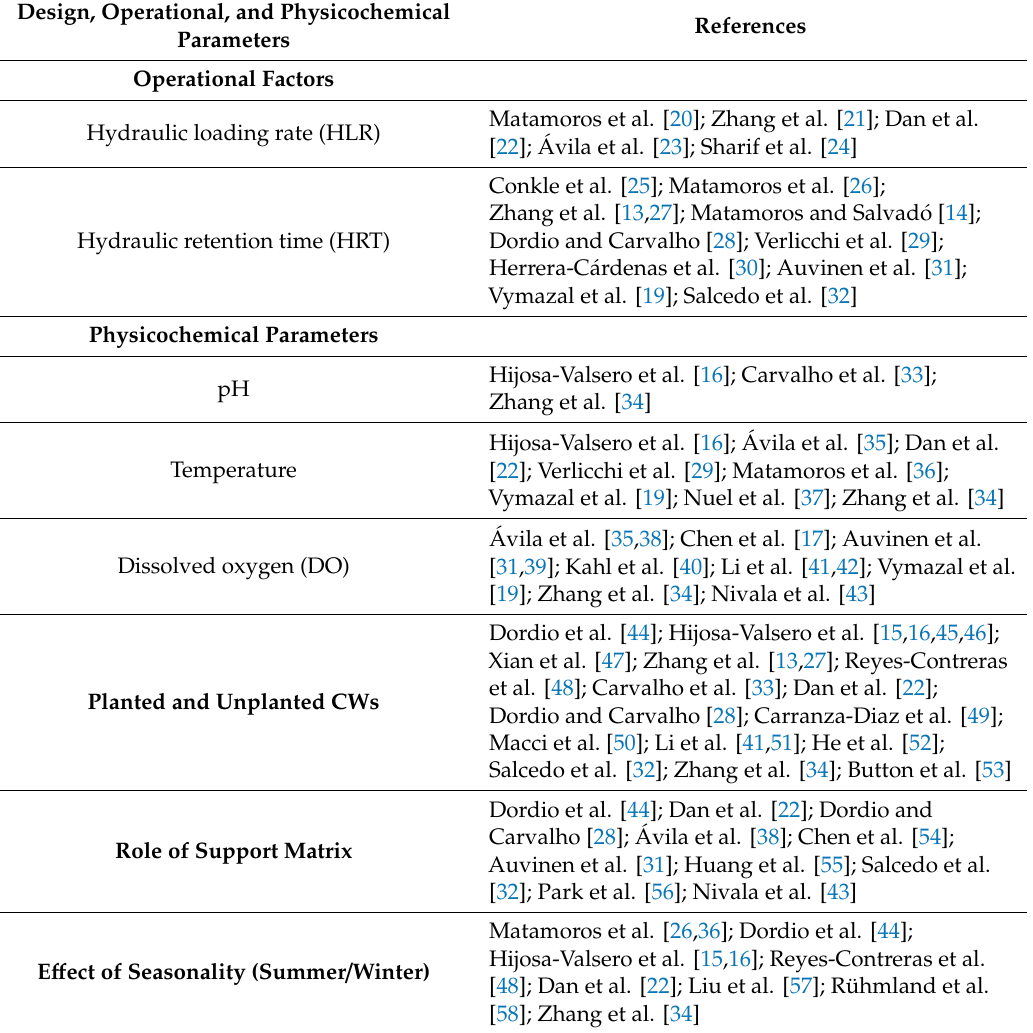
Table 1. The design, operational, and physicochemical parameters of studied constructed wetlands (CWs) and corresponding